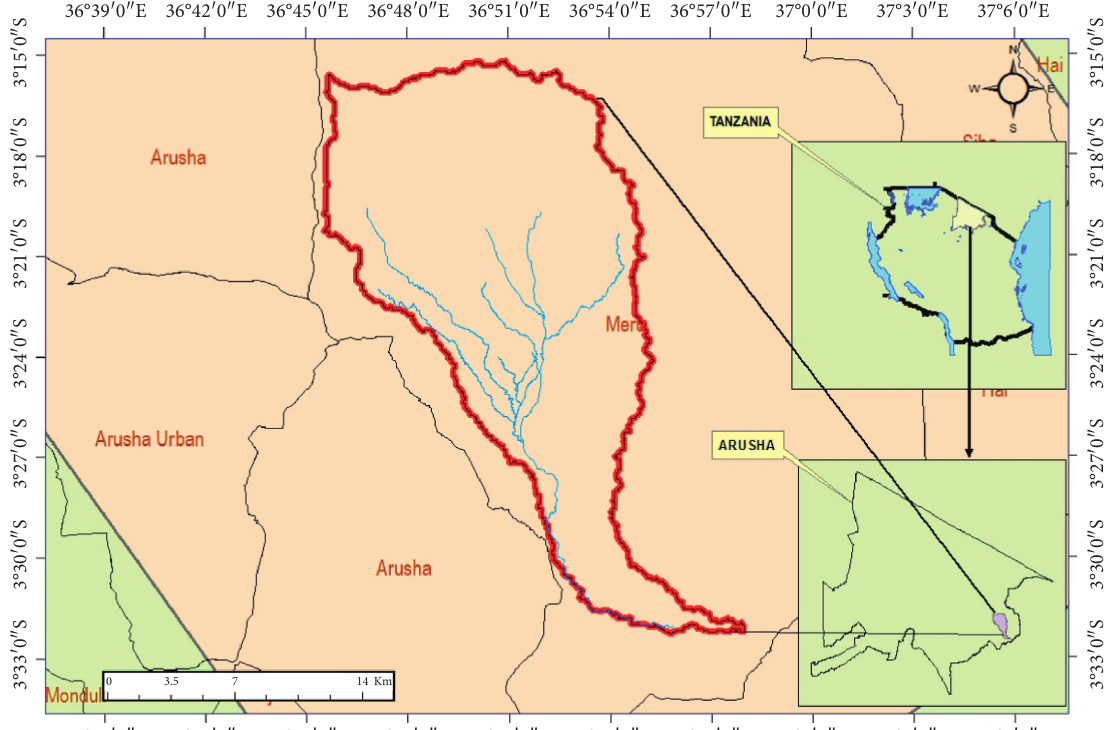
Figure 2: Usa river catchment